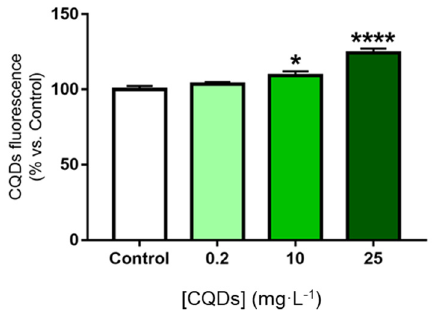
Figure 4. Fluorescence emission in 3T3-L1 cell cultures exposed for 6 h to increasing concentration of CQDs in the absence of serum. Control cells were cultured in medium (DMEM) alone. Measurements were carried out at fluorescence excitation wavelength of 365 nm and emission wavelength of 450 nm. Data (mean ± SEM of at least three independent experiments with three replicate wells per treatment) were analyzed by one-way ANOVA multiple comparison test followed by Fisher’s LSD test. Significant differences are indicated as * p < 0.05, **** p < 0.001 vs. control.